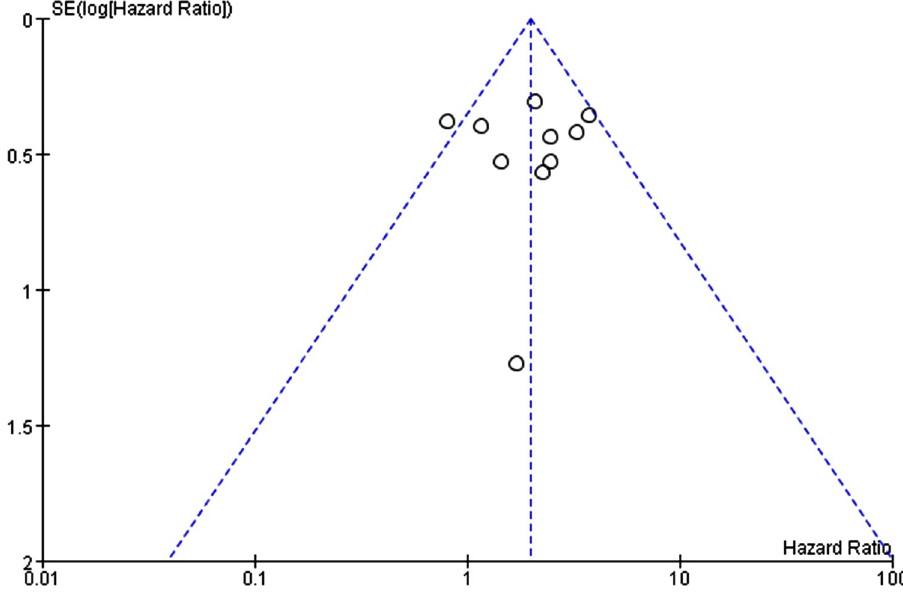
Fig 16. Funnel plot of the association between heart disease and bullous pemphigoid